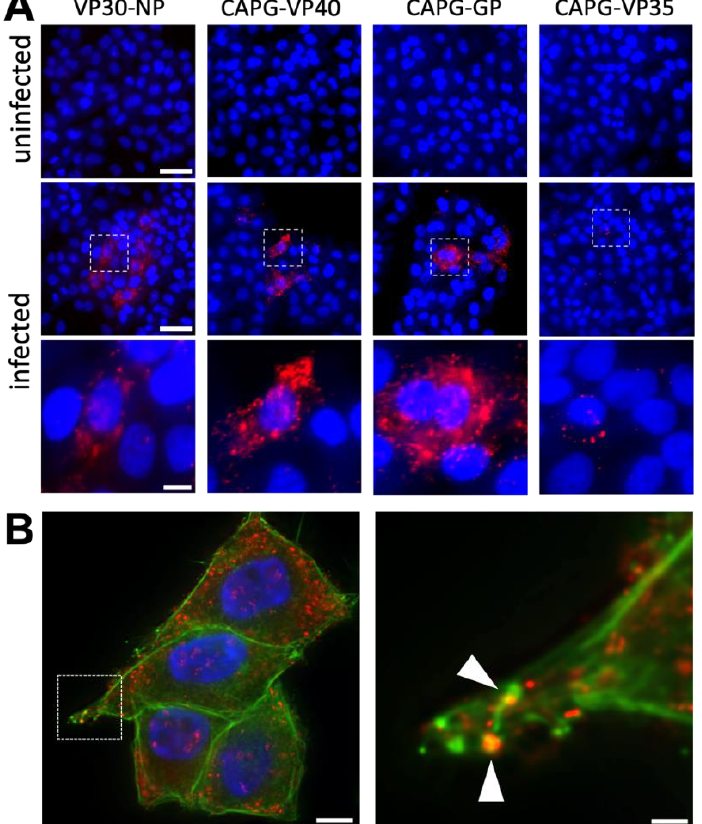
Figure 4. EBOV proteins localize in close proximity to CAPG in the cell cytoplasm. ( A ) Proximity ligation assays were used to detect CAPG and viral protein association. Hela cells were infected with WT-EBOV for 24 h, then fixed and permeabilized. Cells were treated with the indicated antibodies specific for each native protein and detected protein complexes stained red. Cell nuclei were stained with Hoechst 33342 (blue). The lower set of images from infected cells are magnified from the indicated sections of images (dotted squares). Scale bars = 50 µm, and 10 µm in magnified images. ( B ) A representative image (left) of amplified signal (red) of VP40-CAPG and phalloidin (green). The images were taken from the middle z-plane from an image stack. A magnified image (right) is shown for a region indicated by the dotted square. Arrowheads indicate sites where CAPG-VP40 complexes and phalloidin staining (F-actin) overlap. Scale bar = 10 µm and 2 µm in the magnified images.